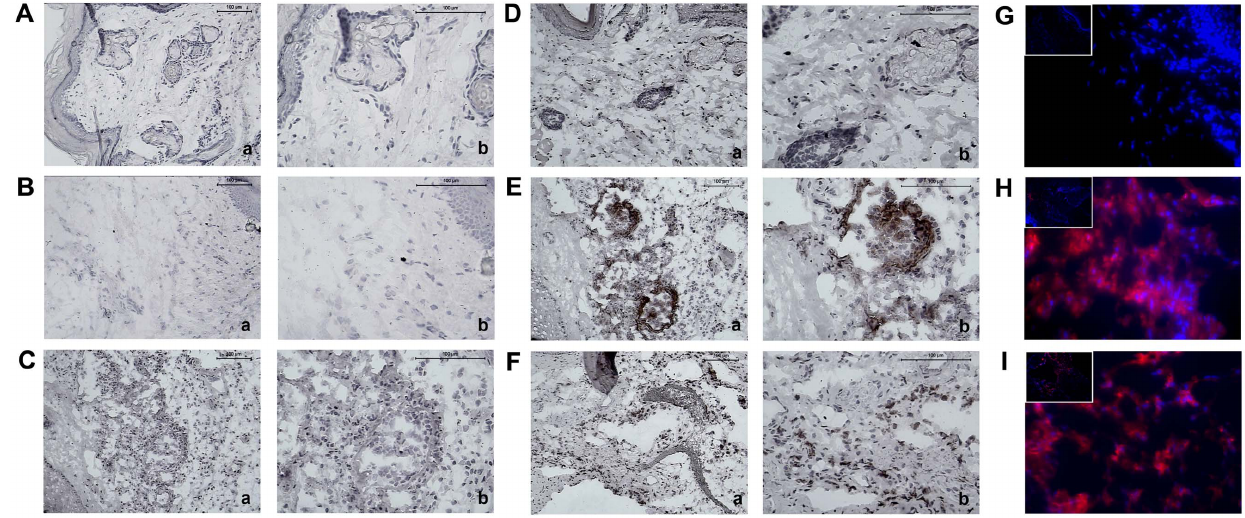
Figure 5. Injection of the P.semirufa bristle extract induces neutrophil infiltration at the inoculation site. BALB/c mice were repeatedly injected with 50 m L of pyrogen-free saline with or without 10 m g (protein) of the extract in the footpad and, after the 1 st , 3 rd , 5 th and 7 th inoculations, the footpads were removed and frozen for immunohistochemistry and immunofluorescence analyses. Representative photomicrographs of left hind footpads stained with Ly6G, injected once ( A and B ) or seven times ( D and E ) with saline and P. semirufa bristle extract, respectively. ( C ) Negative control, injected with extract, marked with matched isotype and ( F ) positive control injected with Carrageenan (200 m g/ paw). Positive immunostaining is indicated by a red-brown colour. Images in panel a are at 200 6 magnification, and images in panel b are at 400 6 magnification. Photomicrograph (400 6 magnification/100 6 magnification in the left upper quadrant) panels G and H show immunofluorescence analysis of groups inoculated one and seven times, respectively, with P . semirufa bristle extract, while panel I shows the group inoculated with Carrageenan. DAPI- labelled nuclei appear blue, while the TRITC-labelled target molecules appear red/magenta.